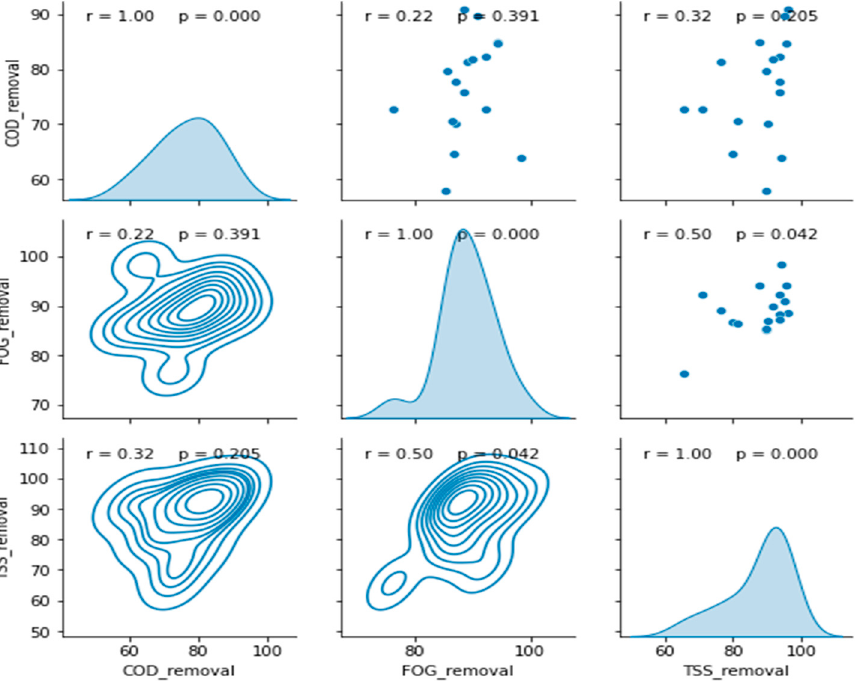
Figure 15. Correlation matrix between the removal efficiencies of the pre-treatment stage coupled with the